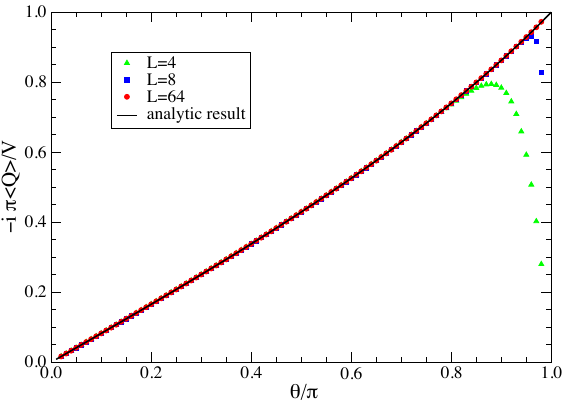
Figure 2 . Topological charge density with 8 (cid:20) L (cid:20) 256 as a function of (cid:18) at (cid:12) = 10 : 0.